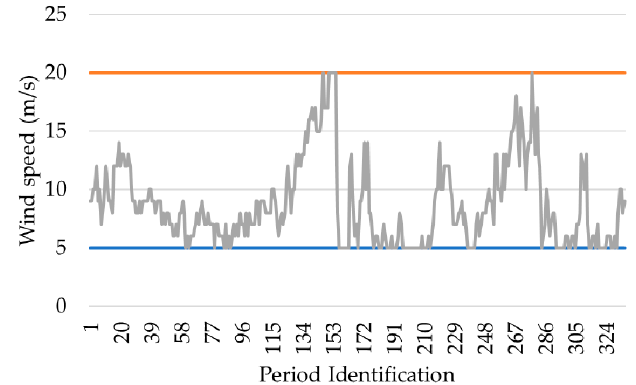
Figure 3. Cut-in and cut-out speed.